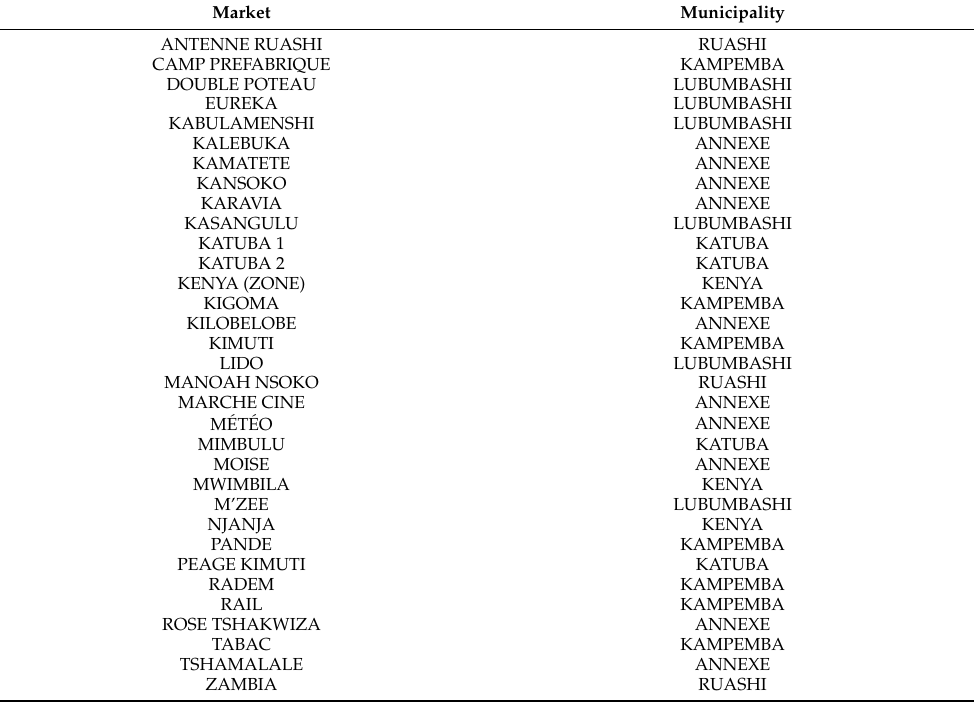
Table A2. Urban markets of Lubumbashi.